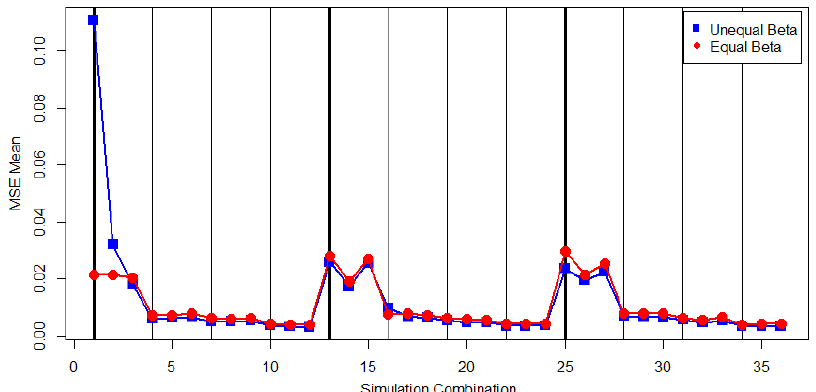
Figure 4. The value of expected absolute error (EAE; ˆ δ SE ) for the cases of β 1 = β 2 and β 1 (cid:54) = β 2 .